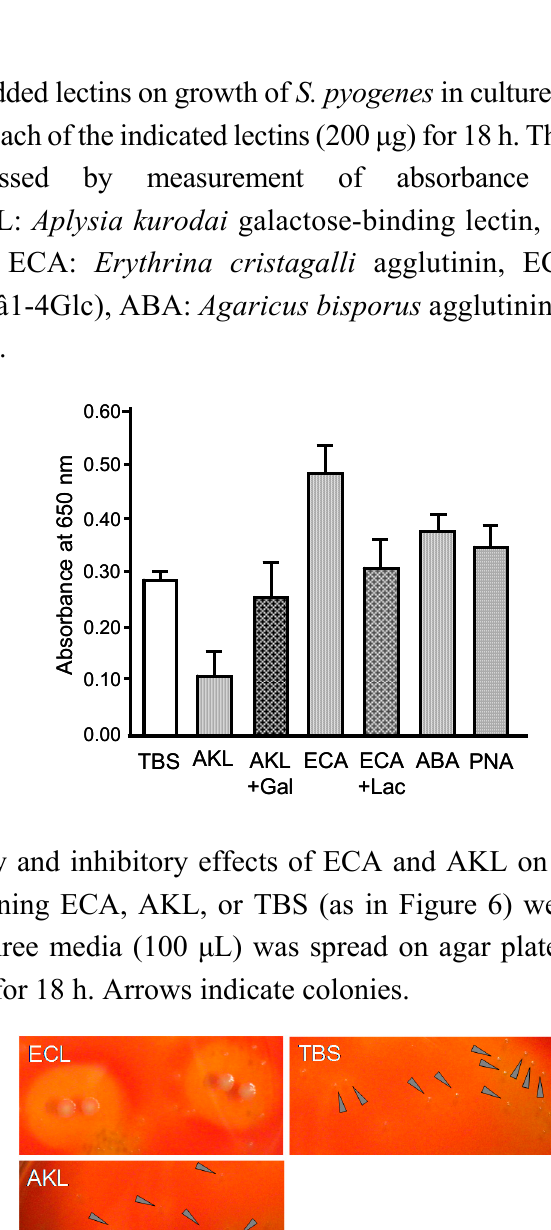
Figure 6. Effects of added lectins on growth of S. pyogenes in culture. S. pyogenes was grown in liquid culture with each of the indicated lectins (200 μg) for 18 h. The turbidity of the culture medium